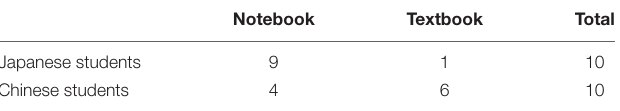
TABLE 2 | Primary materials for note-taking in the Japanese and Chinese groups.